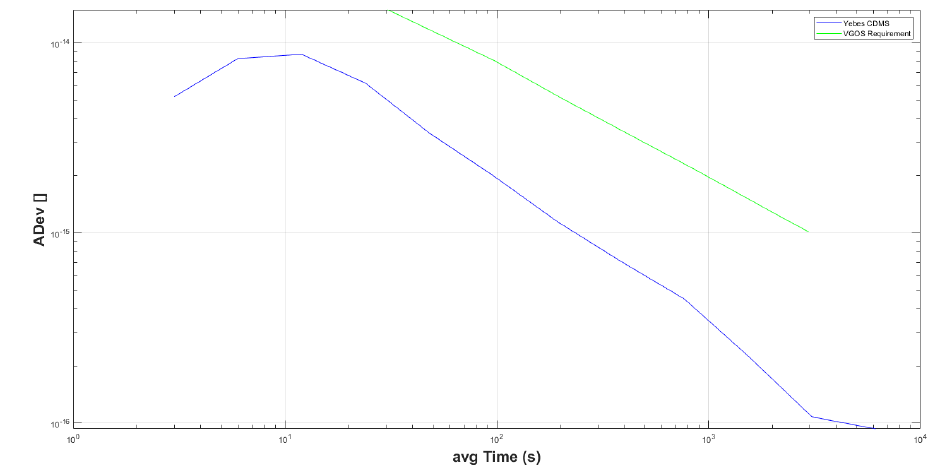
Figure 15. Allan deviation of new GU system in the comparison with VGOS